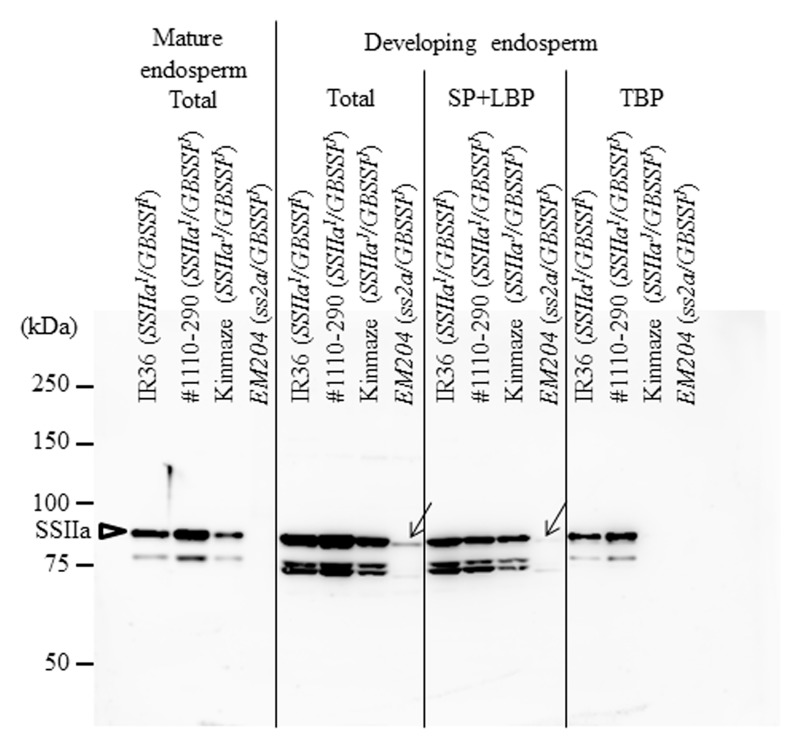
Immunoblotting of mature and developing endosperm using anti-SSIIa serum. Total, total proteins; SP+LBP, soluble and loosely bound protein; TBP, tightly bound protein; IR36, indica rice cultivar, SSIIaI/GBSSII; #1110-290, SSIIaI/GBSSIJ; Kinmaze, japonica rice cultivar, SSIIaJ/GBSSIJ; EM204, ss2a/GBSSIJ. Arrows show the possible truncated SSIIa bands in EM204.